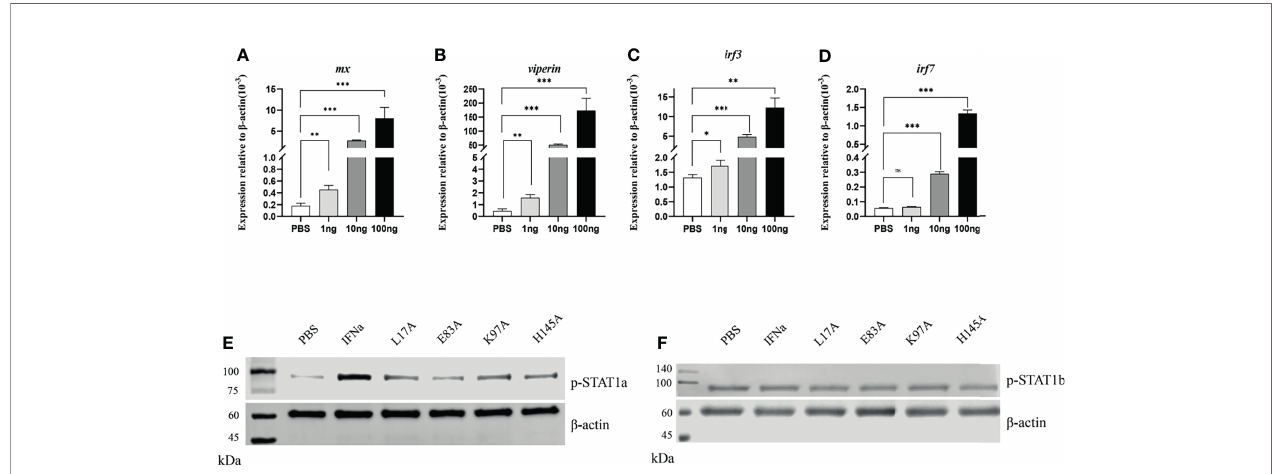
FIGURE 8 | IFNa mutants decreases the phosphorylation of STAT1a but not STAT1b. The EPC cells were stimulated with IFNa derived from HEK293F cells for 6 h. The expression of mx (A) , viperin (B) , irf3 (C) and irf7 (D) was analyzed by qPCR. Data are shown as mean + SEM (N = 4). *P < 0.05, **P < 0.01, or ***P < 0.001 is considered signi fi cant. The EPC cells were transfected with pcDNA3.1- Dr H-STAT1a or pcDNA3.1- Dr H-STAT1b plasmid and stimulated with recombinant wild-type and mutant IFNa proteins derived from HEK293F cells, respectively. Phosphorylation of STAT1a (E) and STAT1b (F) was analyzed by Western blotting. ns, no signi fi cant